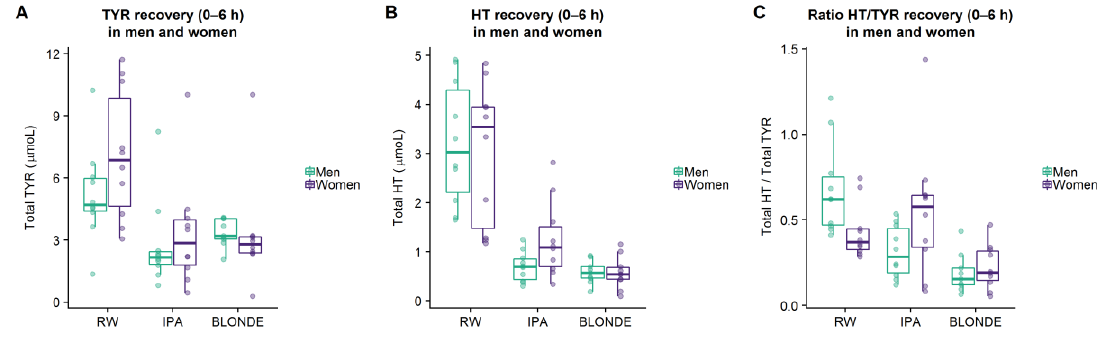
Figure 2. Total tyrosol (TYR) ( A ), total hydroxytyrosol (HT) ( B ), and the ratio between total HT:total TYR recoveries ( C ) collected from 0 to 6 h for different interventions stratified by sex.